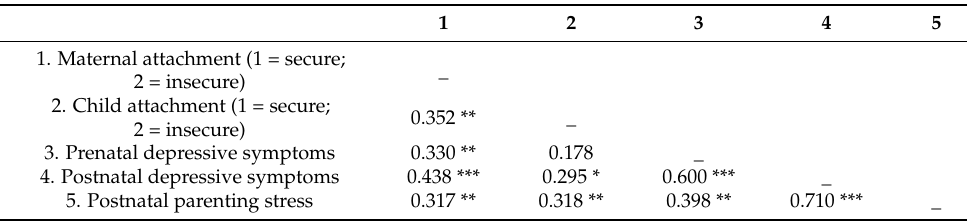
Table 2. Bivariate intercorrelations among study